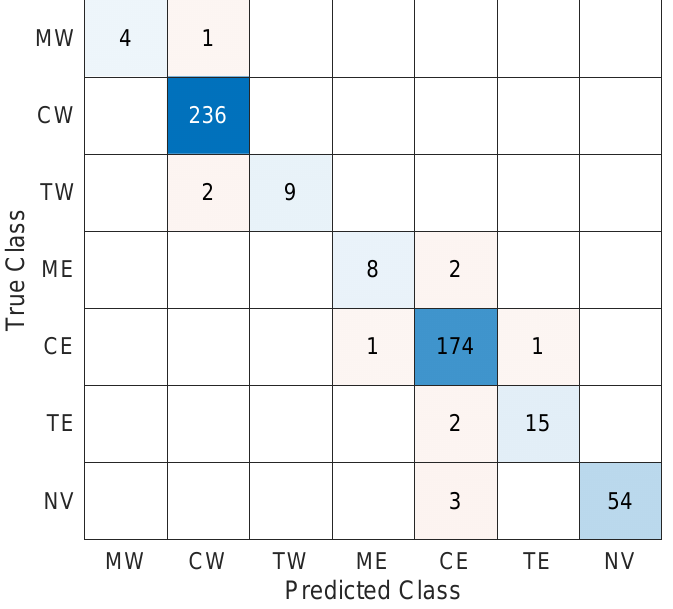
Figure 10. Confusion matrix showing the classification outcome for the different classes. The rows correspond to the true class, and the columns to the predicted